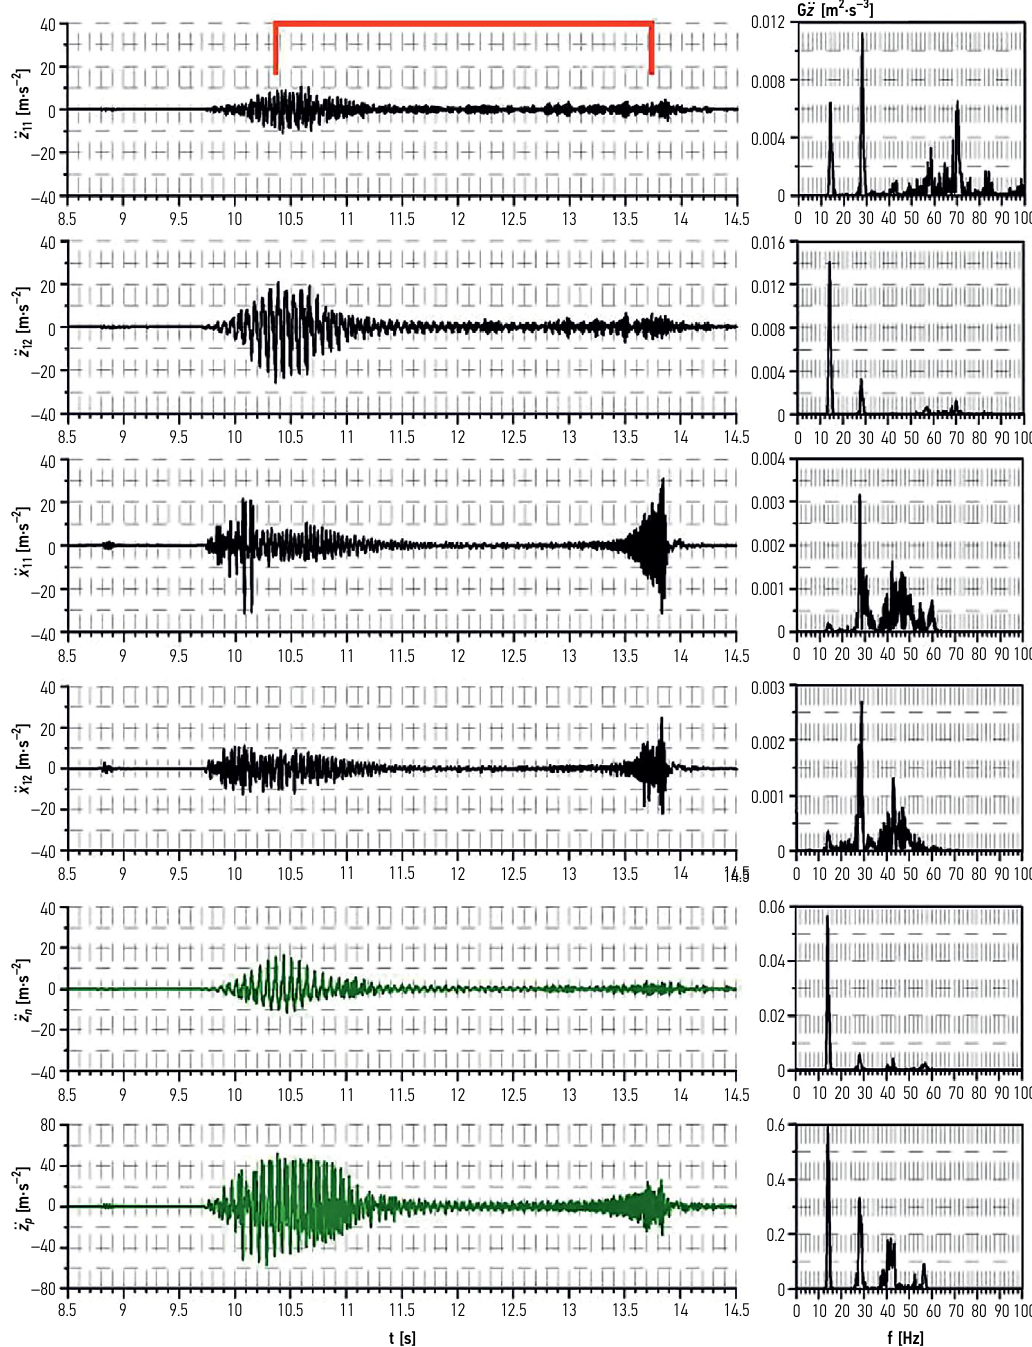
Fig. 8. Acceleration signals measured by the sensors the position of which is indicated in Fig. 3 and their spectral analysis (power spectral densities), experiment